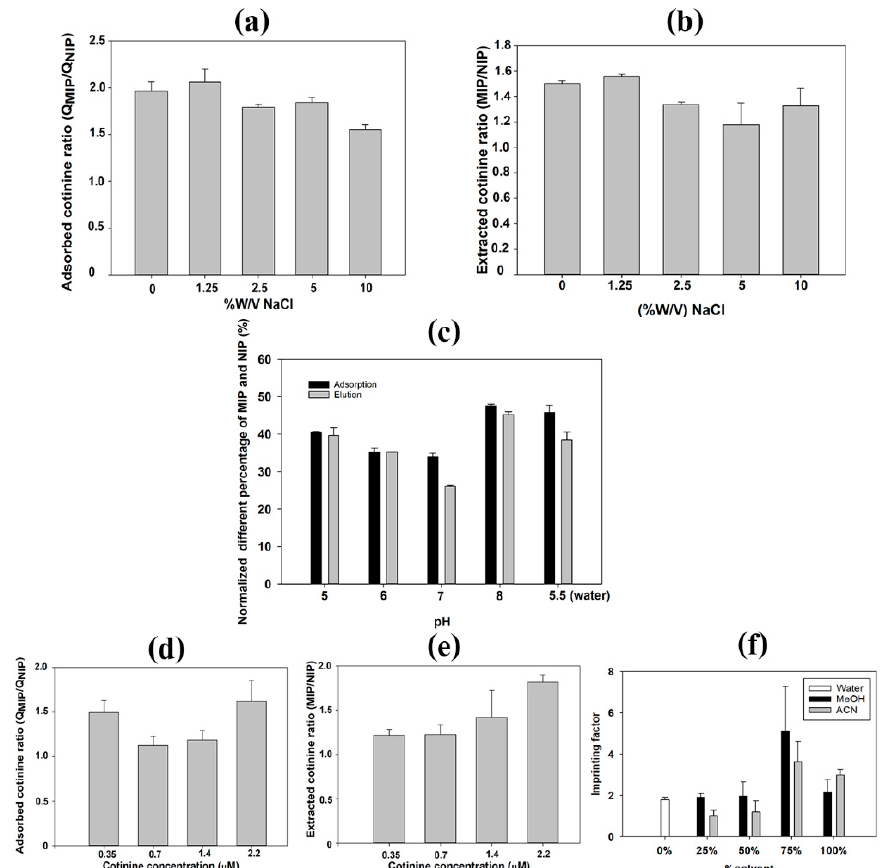
Figure 6. Effects of NaCl, pH, sample matrix, and solvent on cotinine adsorption and extraction. ( a ) Effect of NaCl on adsorbed cotinine ratio between MIPs and NIPs. ( b ) Effect of NaCl on peak area ratio of cotinine extraction. ( c ) Effect of pH on normalized different percentage of MIPs and NIPs. ( d ) Effect of sample matrix on adsorbed cotinine ratio between MIPs and NIPs. ( e ) Effect of sample matrix on peak area ratio of cotinine extraction. ( f ) Effect of MeOH, ACN, and water on cotinine adsorption on MIP/NIP paper-based scaffolds.